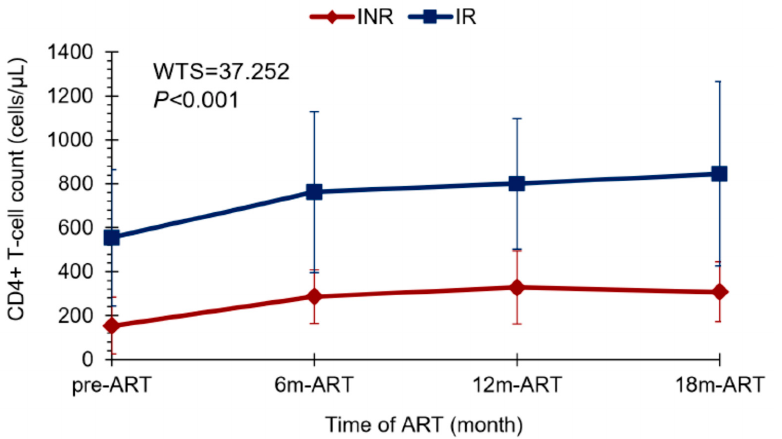
Figure 2. Line plot showing the CD4+ T cell gain profile between the INR and IR groups throughout ART time: pre-treatment, at 6 months, 12 months, and 18 months of ART. Wald-type test: WTS = 37.252; p < 0.001. ART—antiretroviral therapy. INR—immunological non-responders. IR—immunological responders.